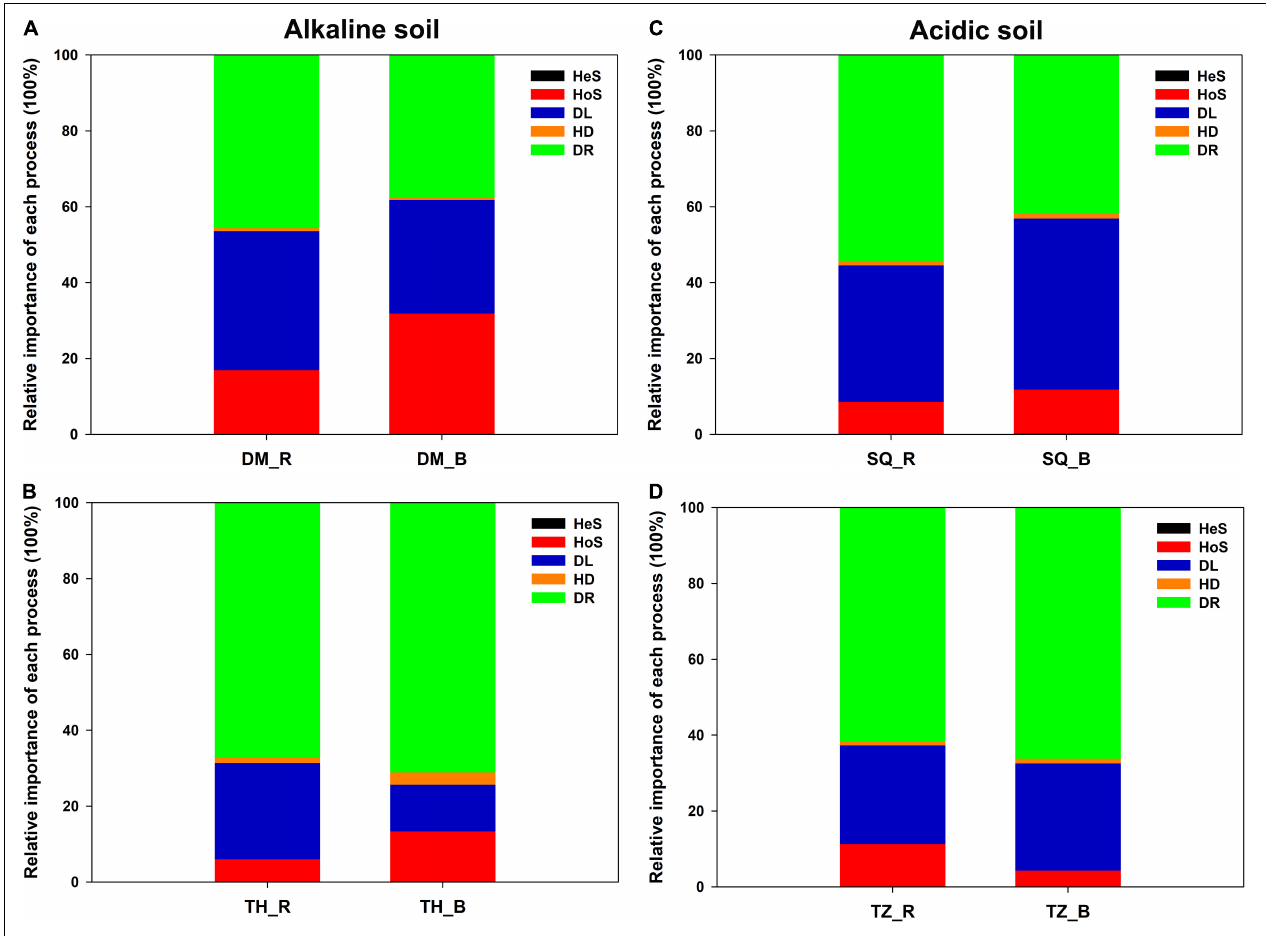
FIGURE 3 | Relative importance of five ecological processes for the assembly of the microeukaryotic communities in the rhizosphere and bulk soils across the four sampling sites [ (A) : Daming [DM], (B) : Taihe [TH], (C) : Sheqi [SQ], and (D) : Tengzhou [TZ]]. Ecological processes include: Dispersal limitation-DL, drift-DR, homogenous dispersal-HD, heterogeneous selection-HeS, and homogenous